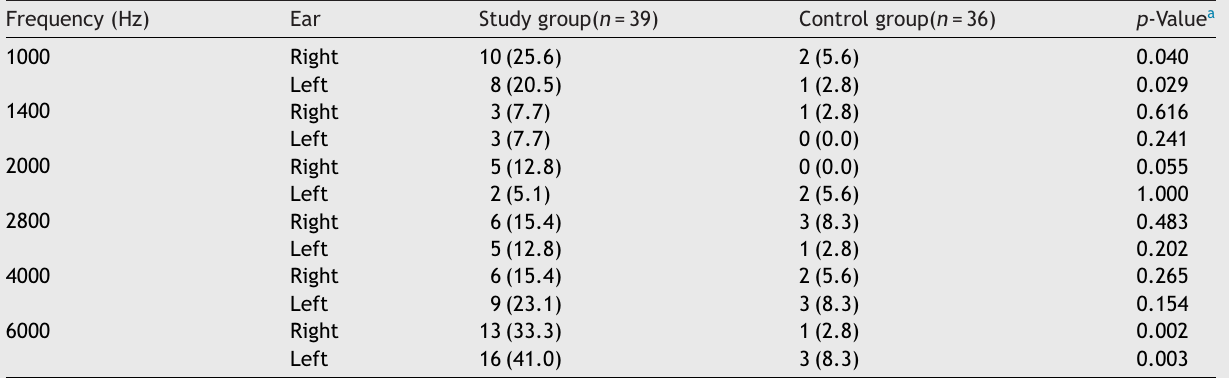
Comparison of alterations in DPOAE by frequency and by ear between groups.